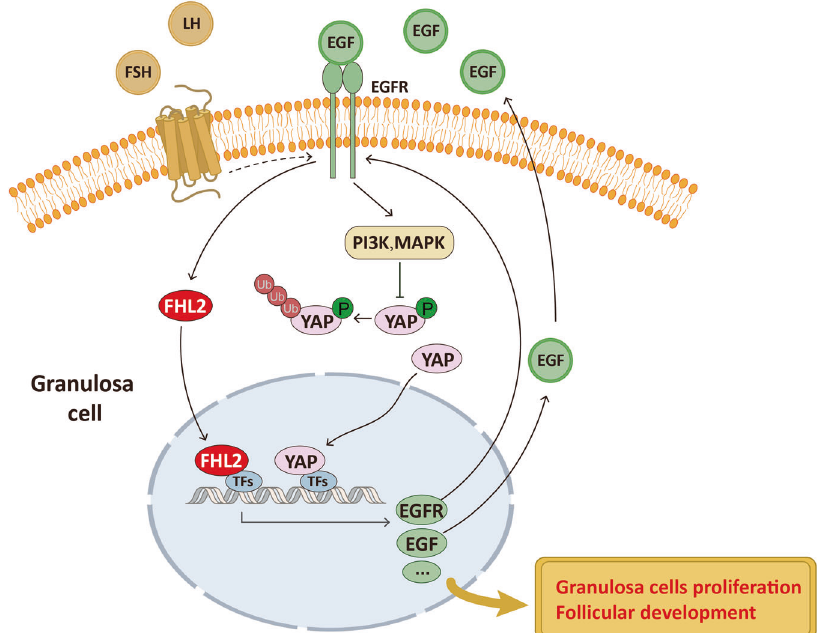
Fig. 7 A schematic diagram showing the proposed mechanism for FHL2 to regulate GC proliferation and follicular